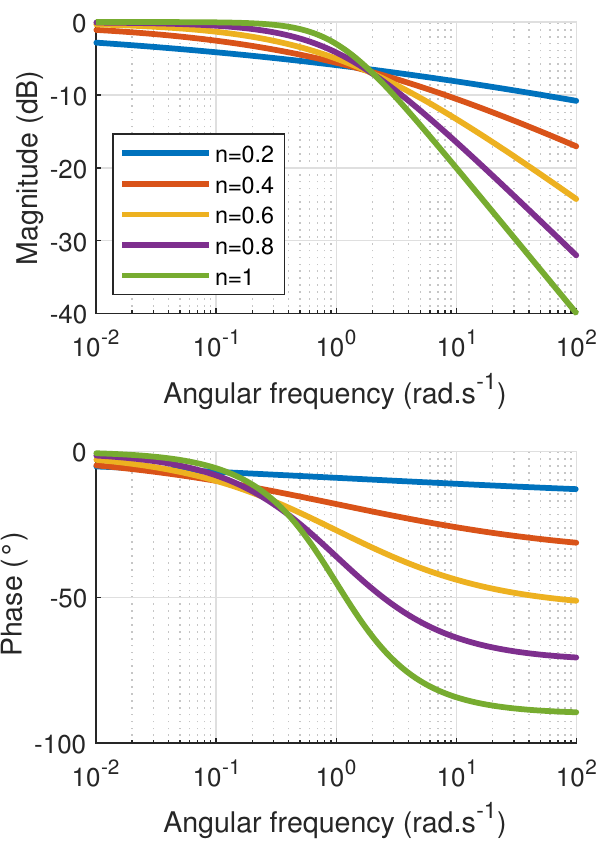
Figure 3. Frequency response of fractional order unit relaxors ( n is the fractional